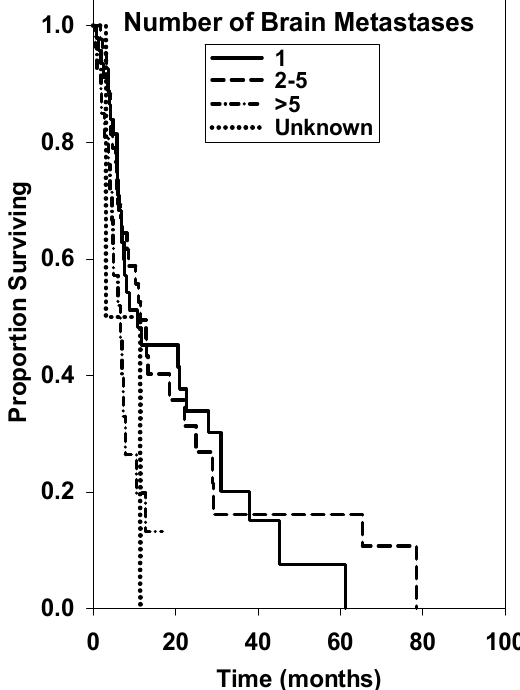
Figure 3. Overall survival curves of patients with 1, 2–5, >5, or unknown number of brain metastases on first diagnosis.